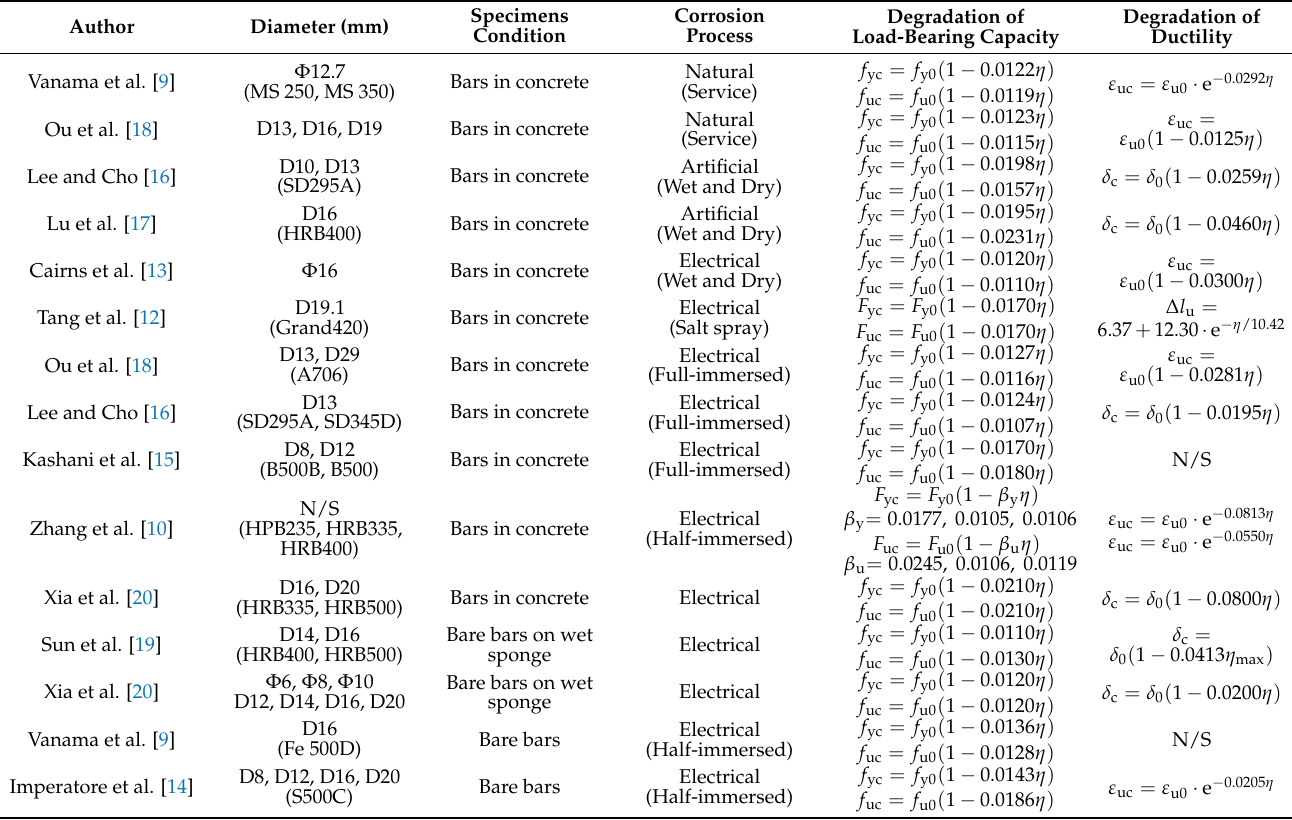
Table 1. Summary of past experimental studies on tensile properties of corroded